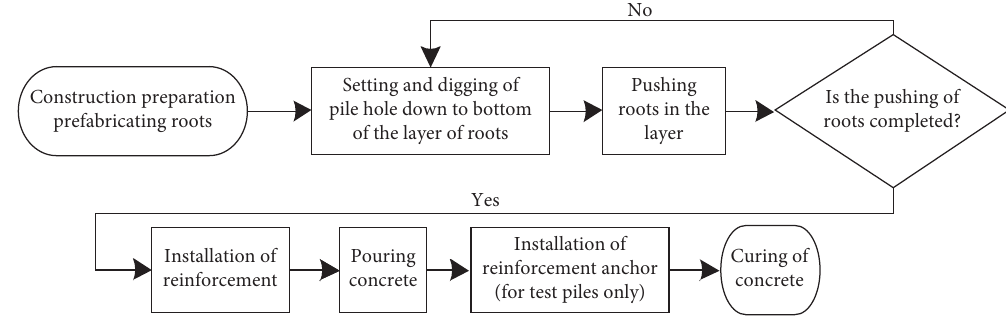
Figure 2: Construction process of